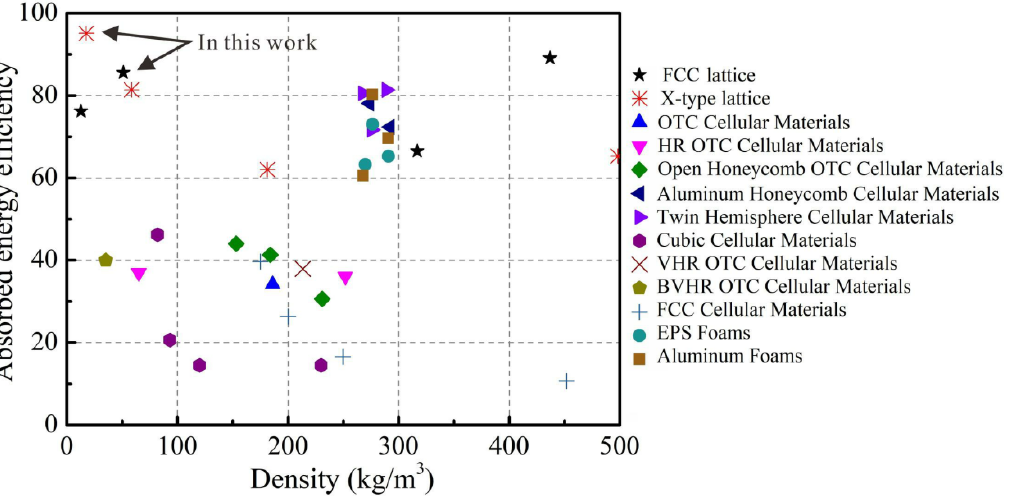
Figure 10. The energy absorption efficiency versus density for micro-architectures compared with competing core topologies.